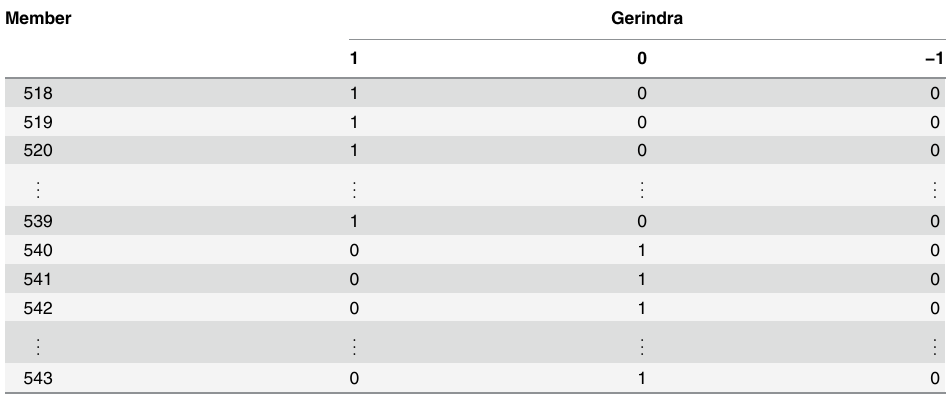
Table 18. A decomposition of Table 10 into multi-tables of Boolean-Valued for Gerindra.